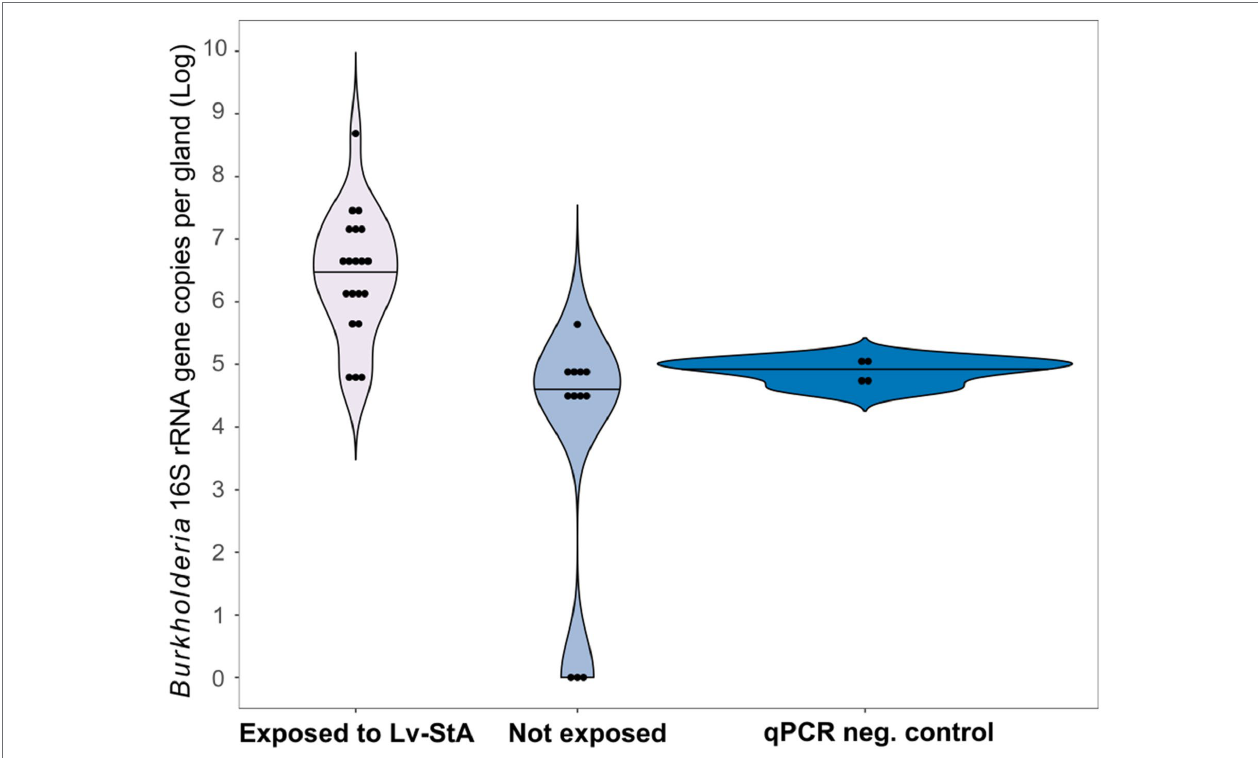
FIGURE 4 | Environmental acquisition of B. gladioli Lv-StA by L. villosa evaluated via qPCR. Abundances of Lv-StA in single glands of adult L. villosa females exposed as aposymbiotic larvae to the bacteria are shown. Detected gene copy numbers of Lv-StA 16S rRNA are significantly higher in individuals that were exposed to infected leaves ( N = 20) than in non-exposed control insects ( N = 12; Wilcoxon Rank Sum test, p < 0.001). Titers in non-exposed beetles were on par with or below qPCR NCs, which include no-template samples (3x) and E. coli genomic DNA (1x). Dots within the violin plot represent individual samples and lines indicate the